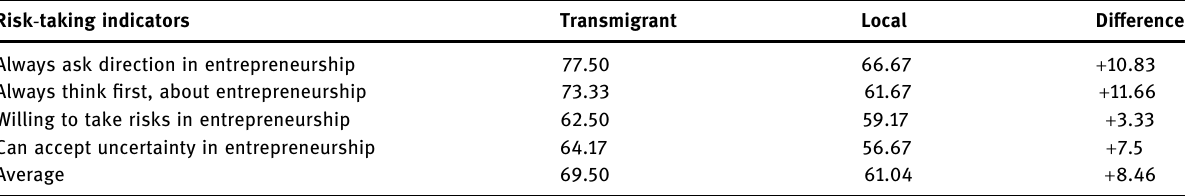
Risk - taking indicators